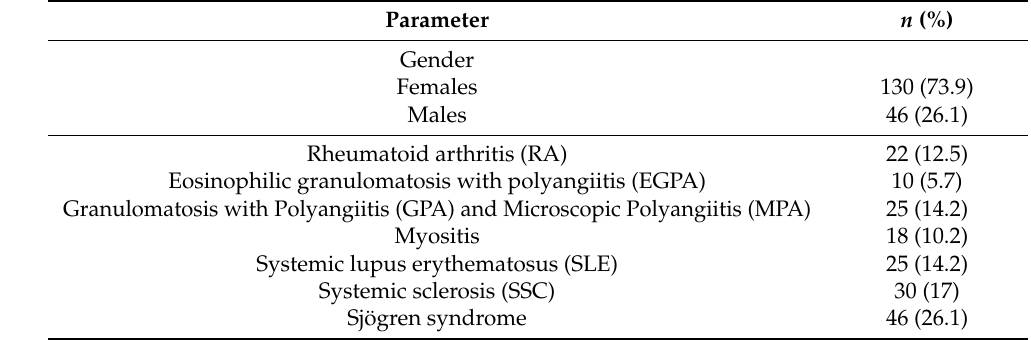
Table 1. Characteristics of the study group.